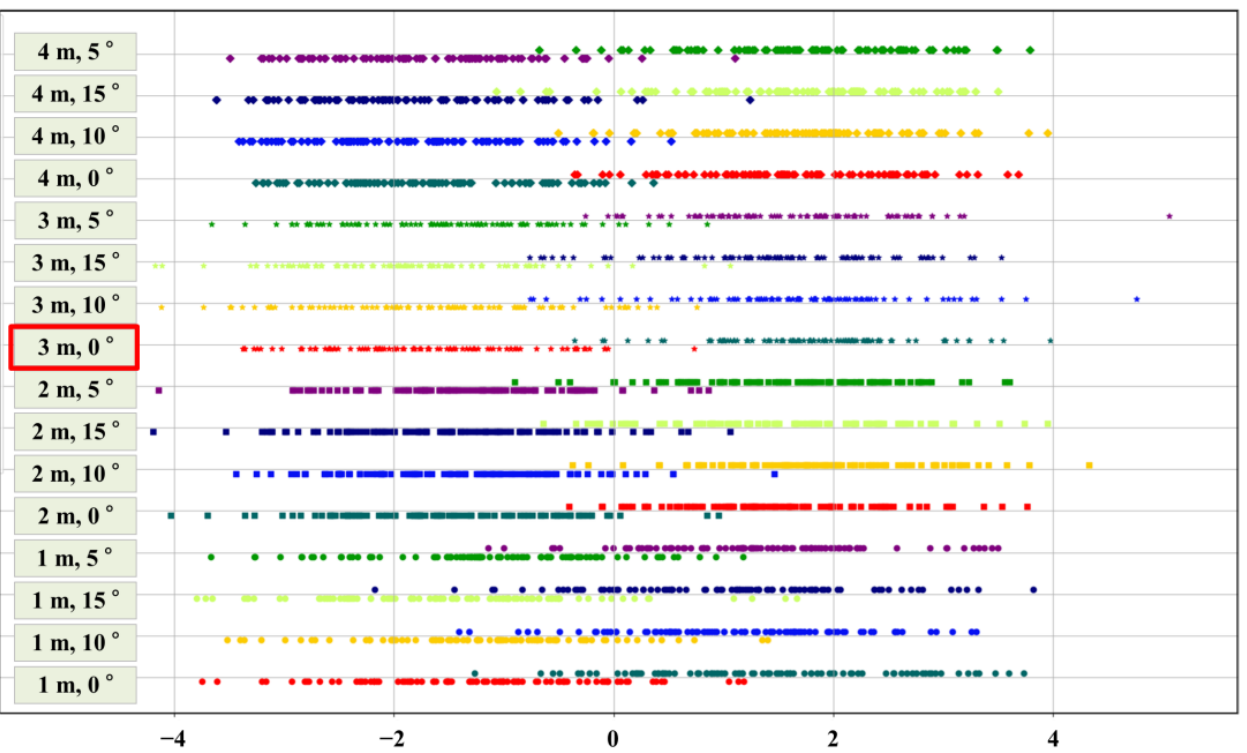
Figure 16. Visualization of LDA results by shooting conditions (The red box indicates the height and angle at which the mean of the gradient magnitude, hue, and saturation LDA is the highest). Figure 18A shows the image of the calibration banner at a distance of 7 m from the camera attached to the drone. The red gridded lines and dots in Figure 18A indicate intersections in the calibration banner, and the red line extending vertically is a straight line that crosses the center of the calibration banner in the longitudinal direction, whereas the blue vertical line crosses the center of the image in the longitudinal direction, revealing that the calibration banner was not placed exactly in the center of the image. To compensate for this, perspective transformation was used. In Figure 18A, with horizontal and vertical dimensions of 5472 and 3648, respectively, the upper-left coordinate of the intersection point of the calibration banner is located at (1329, 2874), while those of the upper-right, lower-left, and lower-right coordinates are (3489, 2872), (759, 3416), and (3990, 3386), respectively. Perspective transformation shifted the ground to the coordinate plane, the horizontal and vertical sizes to 20,000 and 22,000, respectively, the camera coordinates to (7000, 14,000), and the upper-left, upper-right, lower-left, and lower-right coordinates to (4000, 2000), (10,000, 2000), (4000, 6000), and (10,000, 6000) respectively (Figure 18B). As mentioned, since the center of the calibration banner does not coincide with the center of the image, the calibration area was slightly biased to the left (Figure 18B). To compensate for this, the distorted angle was calculated using the resulting angle from the straight line between the center of the camera and the calibration banner, as well as the camera central axis in the perspective-transformed world coordinate system. The resulting distortion angle calculated in the analysis was 3.77 ◦